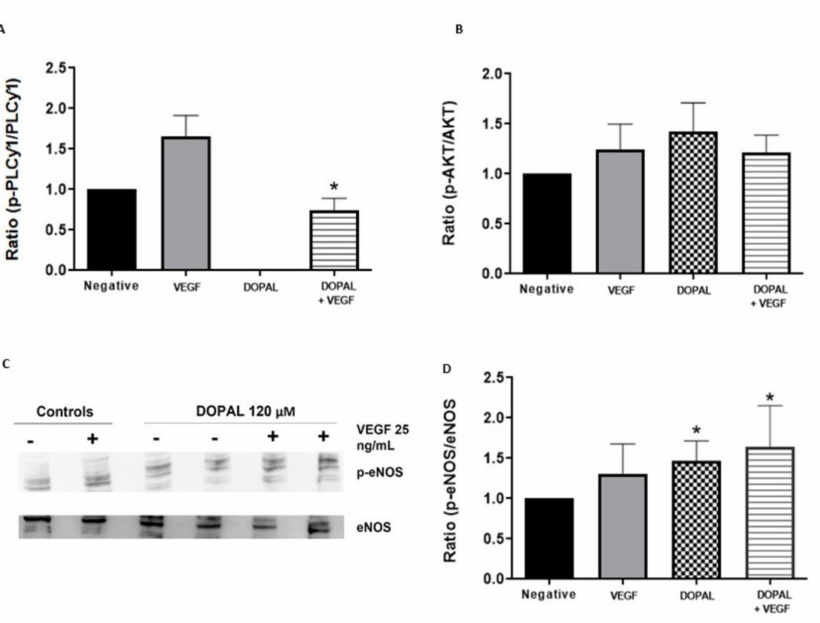
Figure 2. Effects of DOPAL on PLC γ 1, Akt and eNOS. HUVEC cells were treated with DOPAL (120 µ M) for 4 h and then stimulated with VEGF (25 ng/mL) for 10 min ( A ) and 60 min ( B – D ). Western- blot membranes were incubated with anti PLC γ -1 and anti p-PLC γ -1 ( A ), anti Akt and anti p-Akt ( B ) and anti eNOS and anti p-eNOS ( C , D ) antibodies. Data representation of p-PLC γ -1/PLC γ -1, p-Akt/Akt and p-eNOS/eNOS ratio are displayed as mean ± SD ( n = 5). * p < 0.05 against VEGF alone ( A ) and versus negative control ( D ).